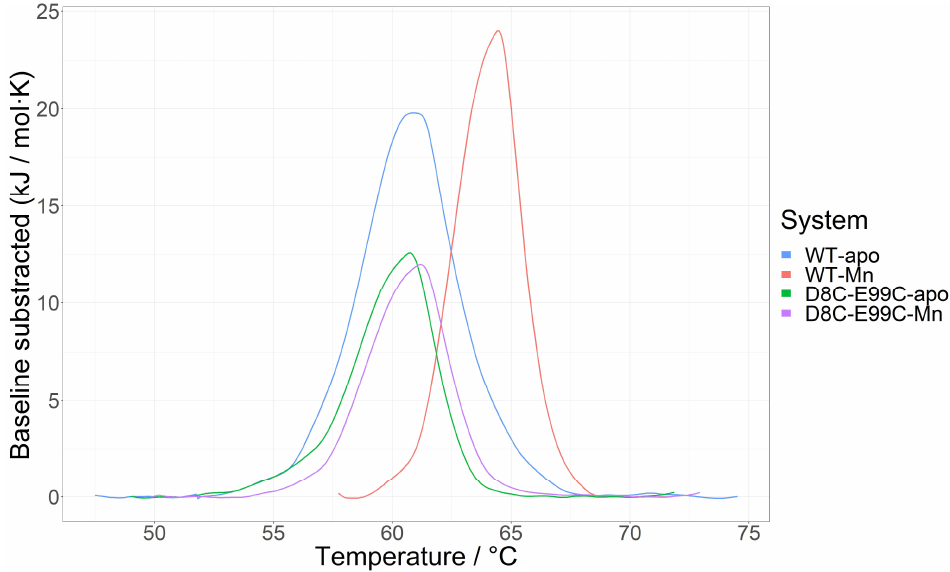
Figure 9. DSC thermograms of apo-MntR (blue trace) and its complex with Mn 2+ (red trace), as well as the D8C-E99C mutant (green trace) and its complex with Mn 2+ (purple trace), represented as baseline subtracted molar heat capacity traces. Samples are prepared in SEC buffer; the buffer-buffer scan was subtracted. Table 3. Thermal unfolding characteristics of apo-MntR and its complex with Mn 2+ , as well as the D8C-E99C mutant and its complex with Mn 2+ , calculated from the DSC scans: Temperature (T m , °C),